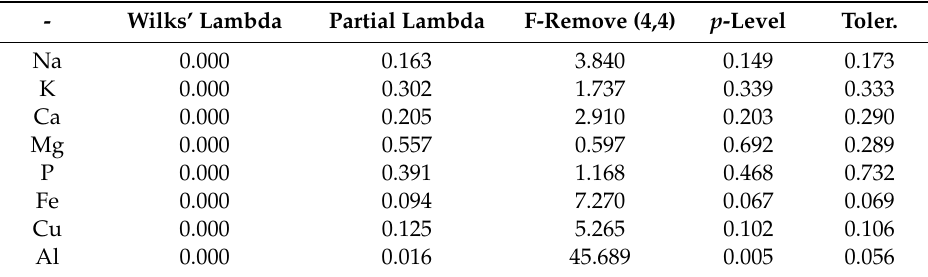
Table 4. Summary of discriminant function analysis.